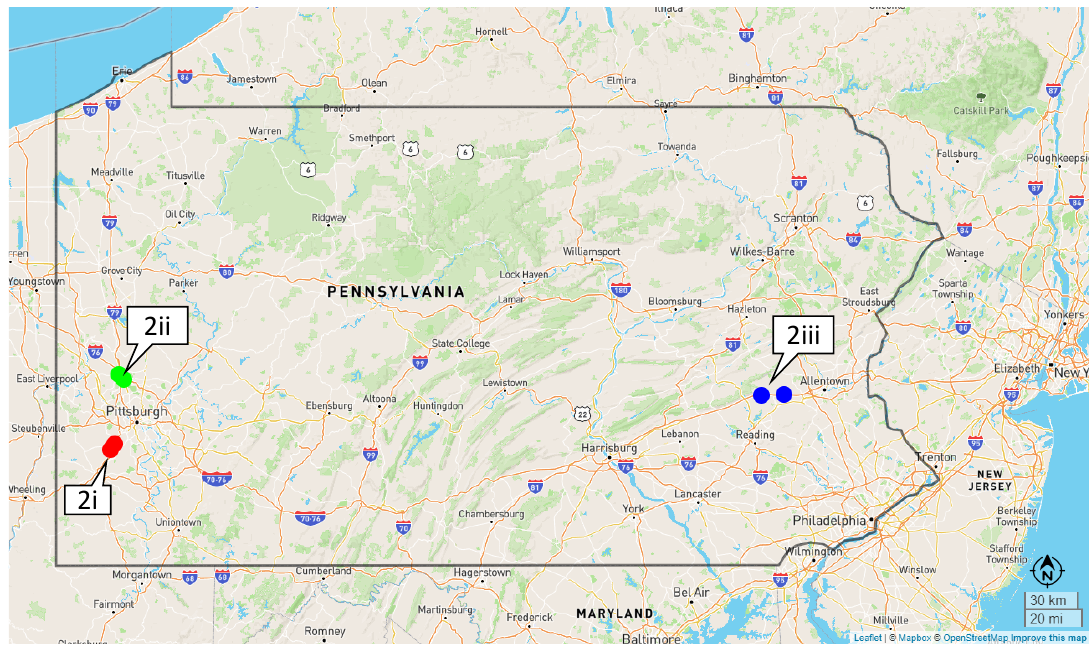
Figure 2. Study work zones in PA with active automated speed enforcement. Callout 2i, 2ii and 2iii shows the I-79, I-76 and I-78 work zones,